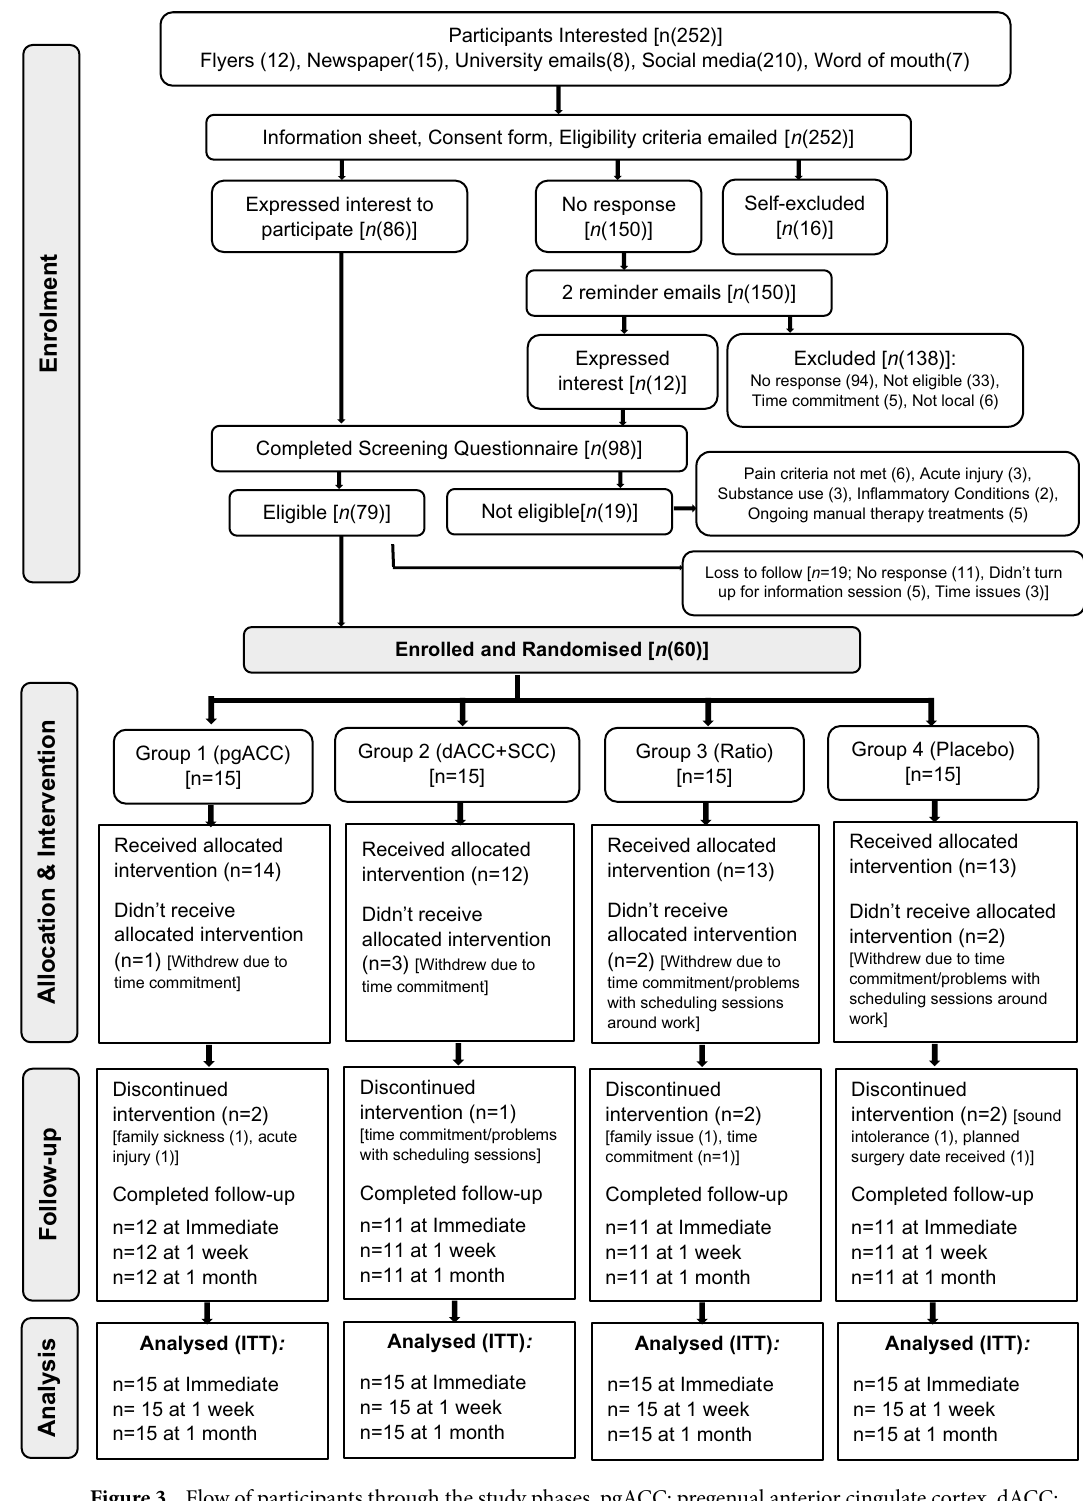
Figure 3. Flow of participants through the study phases. pgACC: pregenual anterior cingulate cortex, dACC: dorsal anterior cingulate cortex, SSC: primary somatosensory cortex, ITT: intention to